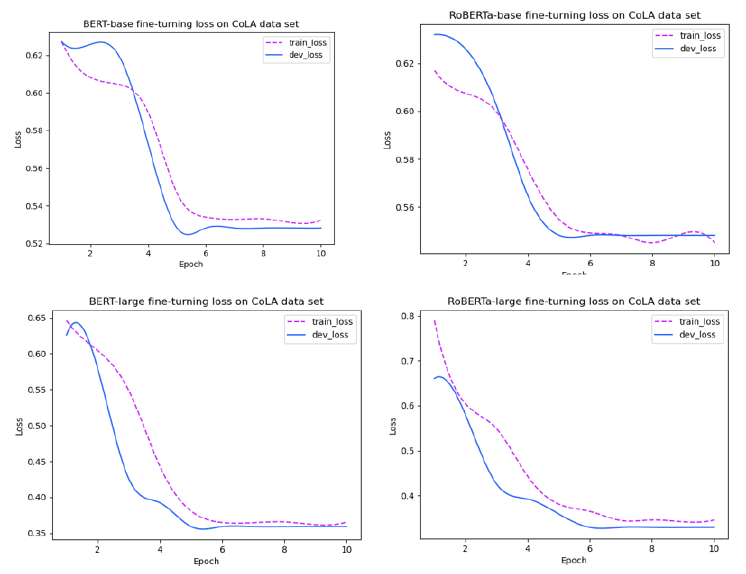
Figure 3. BERT large , BERT base , RoBERTa large , and RoBERTa base model fine-tuned loss rate in CoLA dataset.